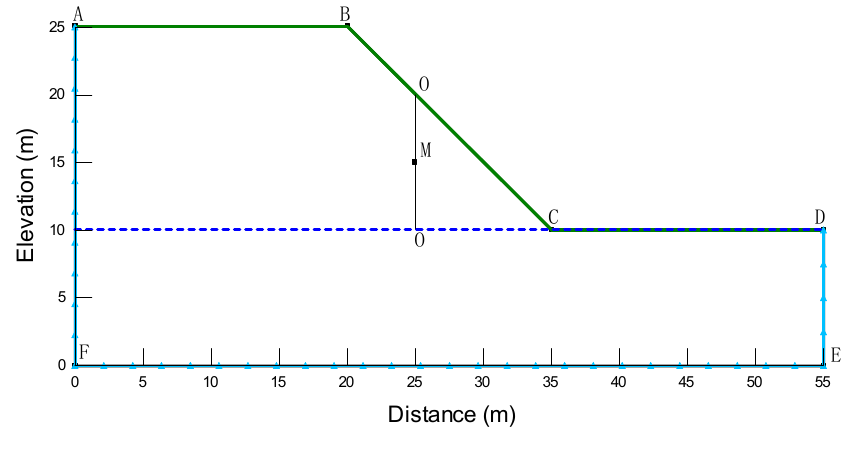
Figure 3. Calculation model.